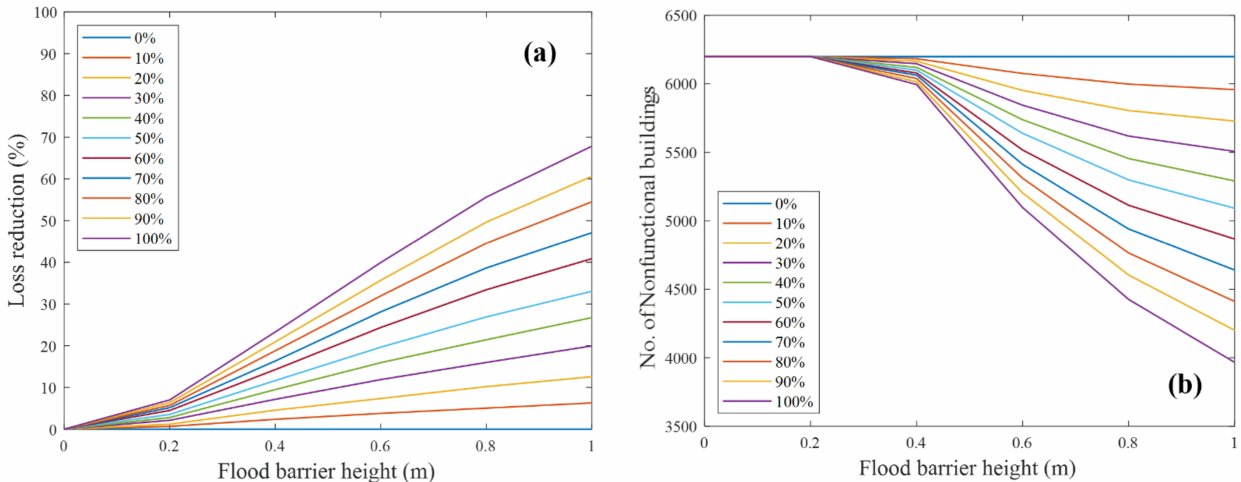
Figure 17. The impact of using flood barriers for all building occupancies using different barrier height corresponding to each response ratio on: ( a ) The percentage of flood loss reduction; ( b ) The number of nonfunctional buildings.